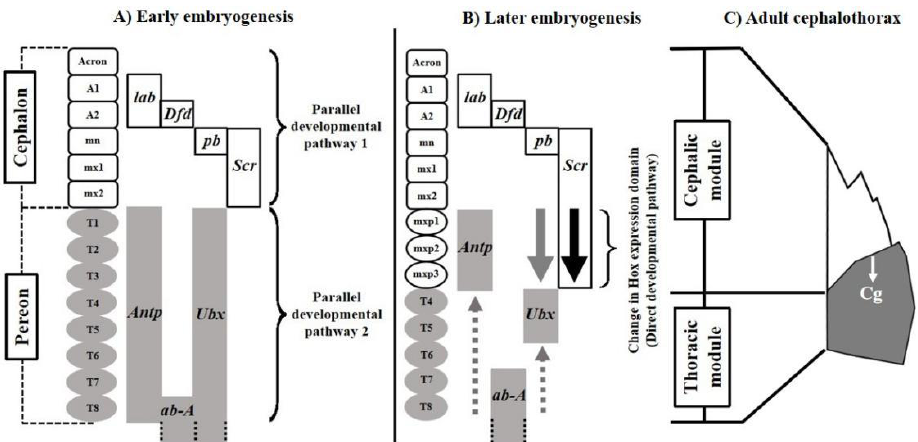
Figure 1. Palimpsest model explaining the origin of the structural complexity of the cephalothorax of decapod crustaceans. ( A ) Parallel developmental pathways regulating the early tagmatization of the cephalon and pereon. ( B ) Change of the Hox regulation as a direct developmental pathway promoting the fusion of the tagmata. ( C ) Structure resulting from the fusion of the developmental mod-